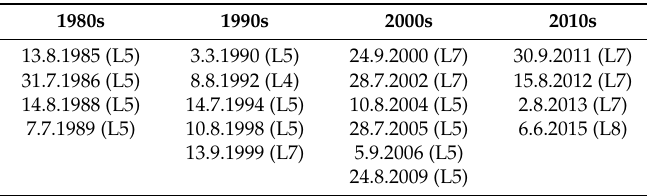
Table 1. List of the Landsat scenes used for the disturbance index (DI) time series analysis (dates of scene acquisition and Landsat satellite: L4: Landsat 4 TM, L5: Landsat 5 TM, L7: Landsat 7 ETM+, L8: Landsat 8